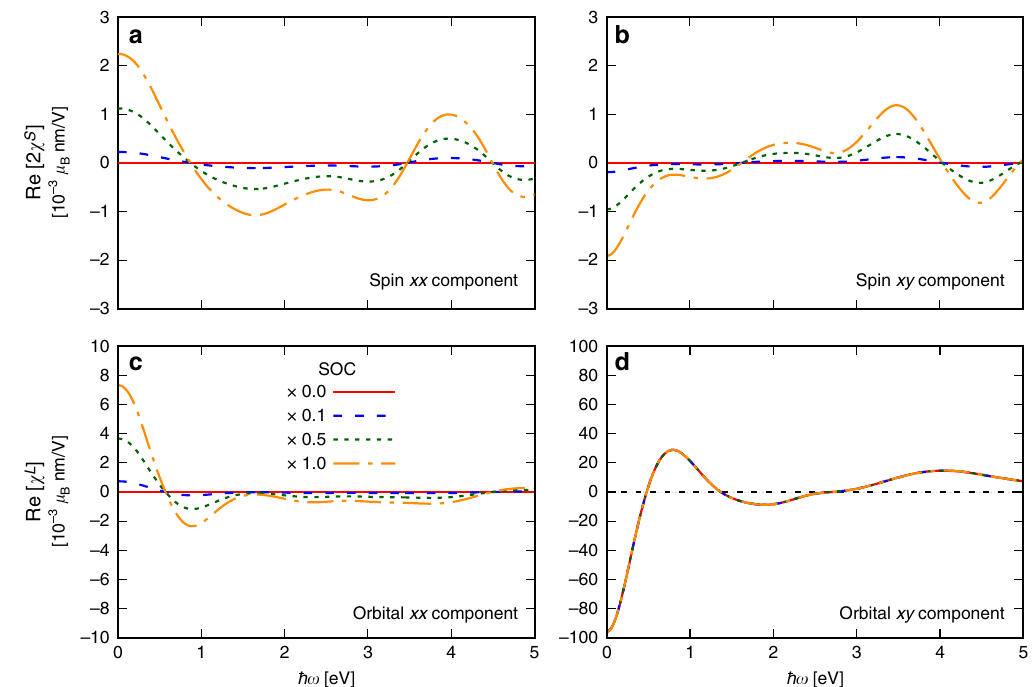
Fig. 5 Rashba-Edelstein effect as a function of spin – orbit coupling strength. Calculated results are given for the Mn 1 atom of antiferromagnetic CuMnAs with moments along the c -axis, for scaled values of the SOC, as given in the legend. a , b The results for the Re ½ χ S the spin REE susceptibility tensor. c , d The results for the Re ½ χ L frequency _ ω